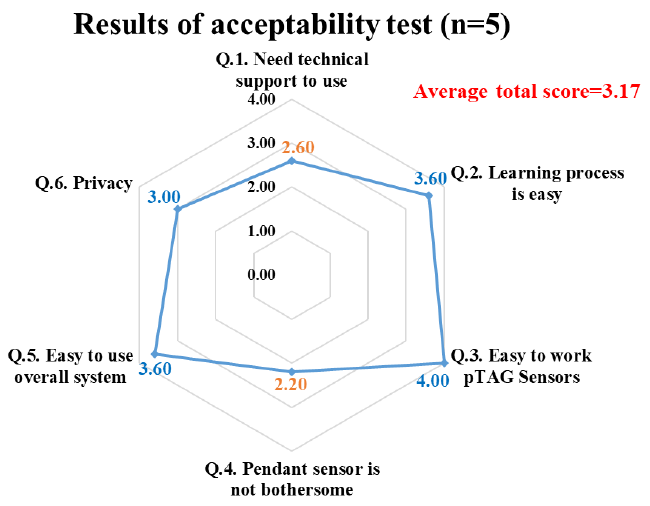
Figure 8. Results of acceptability test for IADLSys.